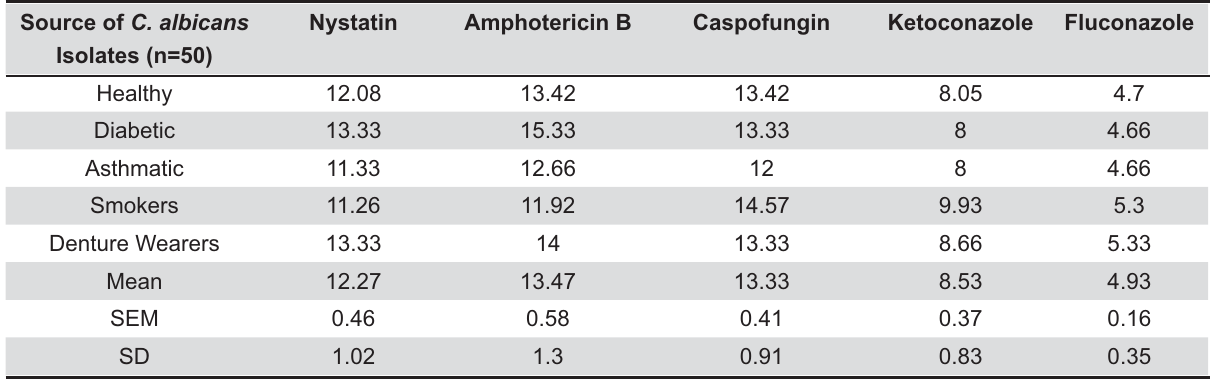
Table 3- Summary of the mean percentage suppression of hemolysin activity in 50 oral C. albicans isolates following 1 hour (cid:3)!"(cid:5)(cid:18)(cid:16)(cid:2)(cid:3)(cid:9)(cid:7)(cid:14)(cid:12)(cid:9)(cid:18)(cid:16)(cid:29)(cid:18)(cid:3)(cid:30)(cid:16)(cid:3)(cid:14)(cid:15)(cid:9)(cid:2)(cid:3)(cid:4)(cid:5)(cid:6)(cid:7)(cid:8)(cid:9)(cid:5)(cid:10)(cid:9)(cid:11)(cid:6)(cid:3)(cid:9)(cid:12)(cid:13)(cid:10)(cid:10)(cid:3)(cid:2)(cid:3)(cid:14)(cid:15)(cid:9)(cid:7)(cid:14)(cid:15)(cid:13)(cid:10)(cid:16)(cid:14)(cid:17)(cid:7)(cid:8)(cid:9)(cid:7)(cid:17)(cid:3)(cid:14)(cid:15)(cid:18)(cid:19)(cid:9)(cid:20)(cid:7)(cid:21)(cid:22)(cid:9)(cid:6)(cid:7)(cid:8)(cid:16)(cid:3)(cid:9)(cid:13)(cid:14)(cid:12)(cid:13)(cid:21)(cid:7)(cid:15)(cid:3)(cid:18)(cid:9)(cid:15)(cid:22)(cid:3)(cid:9)(cid:4)(cid:3)(cid:7)(cid:14)(cid:9)"(cid:3)(cid:2)(cid:21)(cid:3)(cid:14)(cid:15)(cid:7)(cid:17)(cid:3)(cid:9)(cid:2)(cid:3)(cid:12)(cid:16)(cid:21)(cid:15)(cid:13)(cid:5)(cid:14)(cid:9) of hemolysin activity in 10 oral C. albicans obtained from either healthy individuals, diabetic patients, asthmatic patients, smokers or denture wearers. SD: Standard deviation. SEM: Standard error of